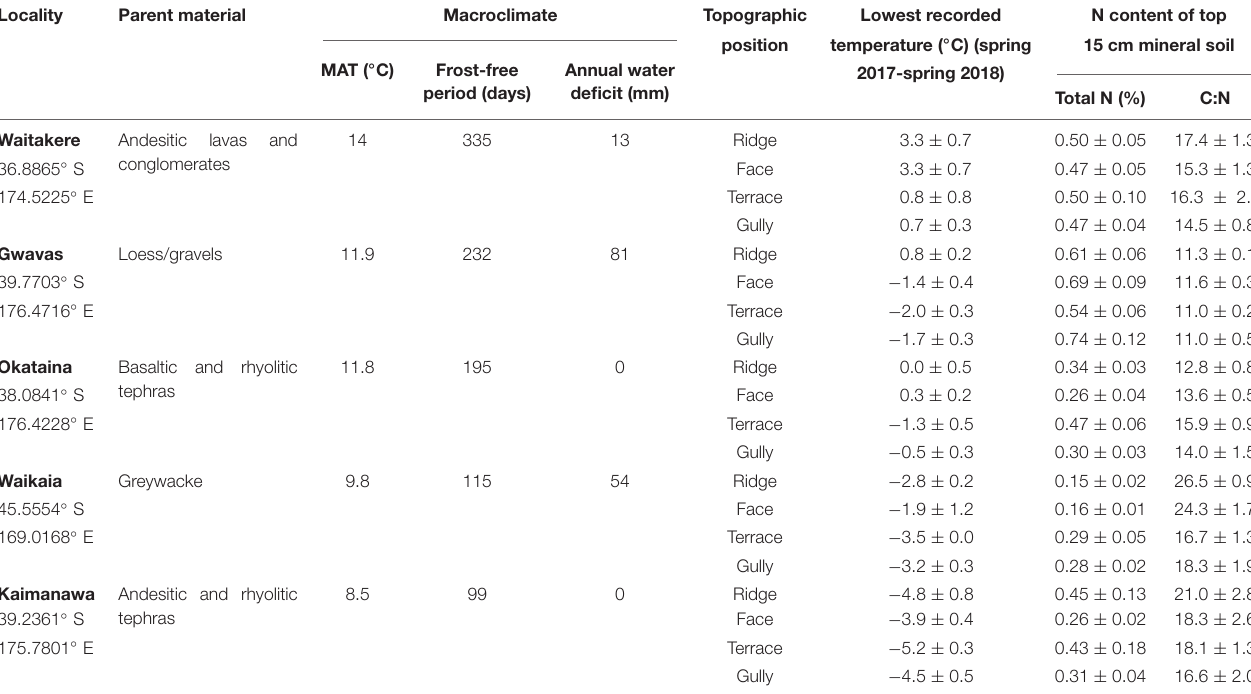
TABLE 3 | Effect of topography on minimum temperatures and soil nitrogen, at five localities differing widely in macroclimate.